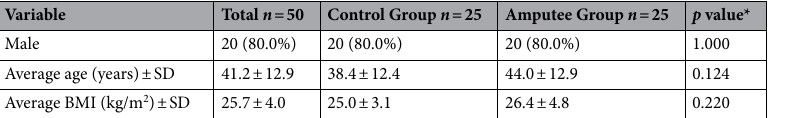
Table 2. Sociodemographic characteristics of participants by study group. BMI Body Mass Index, SD standard deviation. *Mann–Whitney Test.